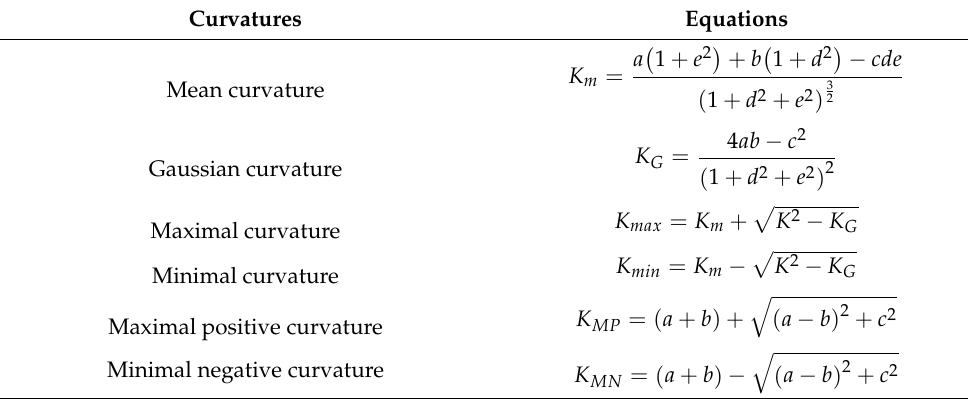
Table 1. Equations for different curvature